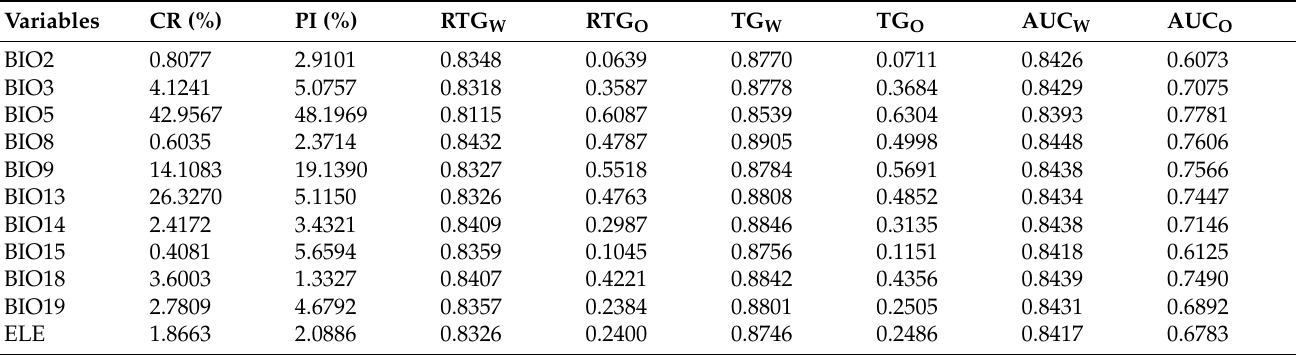
Figure 3. Response curves of presence probability of P. flavescens to max temperature of warmest month ( A ) and precipitation of wettest month ( B ). Table 1. The contribution rate (CR), permutation importance (PI) of filtered environmental factors used in the model prediction, and relevant information of Jackknife test. RTG W , regularization training gain without this variable; RTG O , regularization training gain only with this variable; TG W , test gain without this variable; TG O , test gain only with this variable; AUC W , AUC without this variable; AUC O , AUC only with this variable.